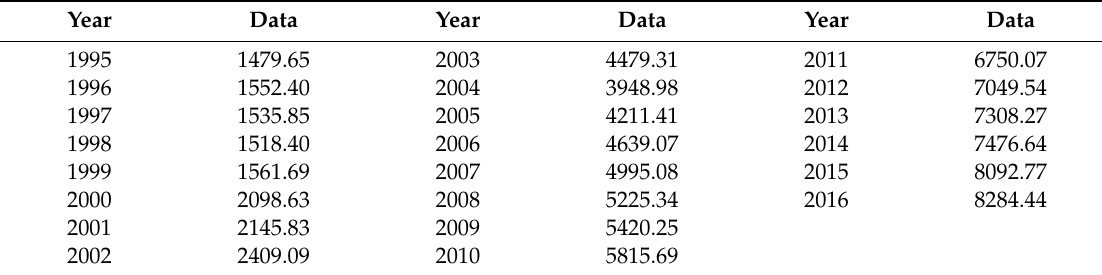
Table 1. The per capita energy consumption data of the Ningxia Hui Autonomous Region (kce / person).